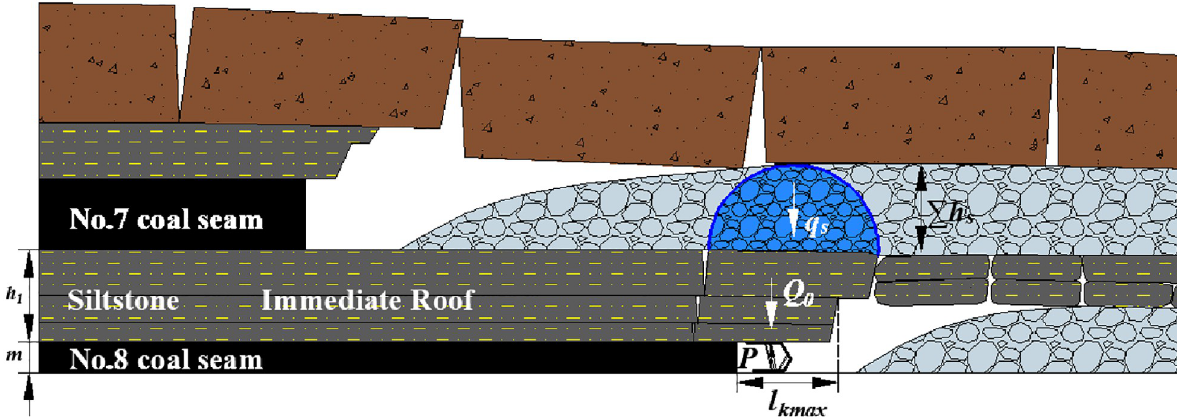
Fig 10. Roof structure characteristic after No.8 coal seam mining.